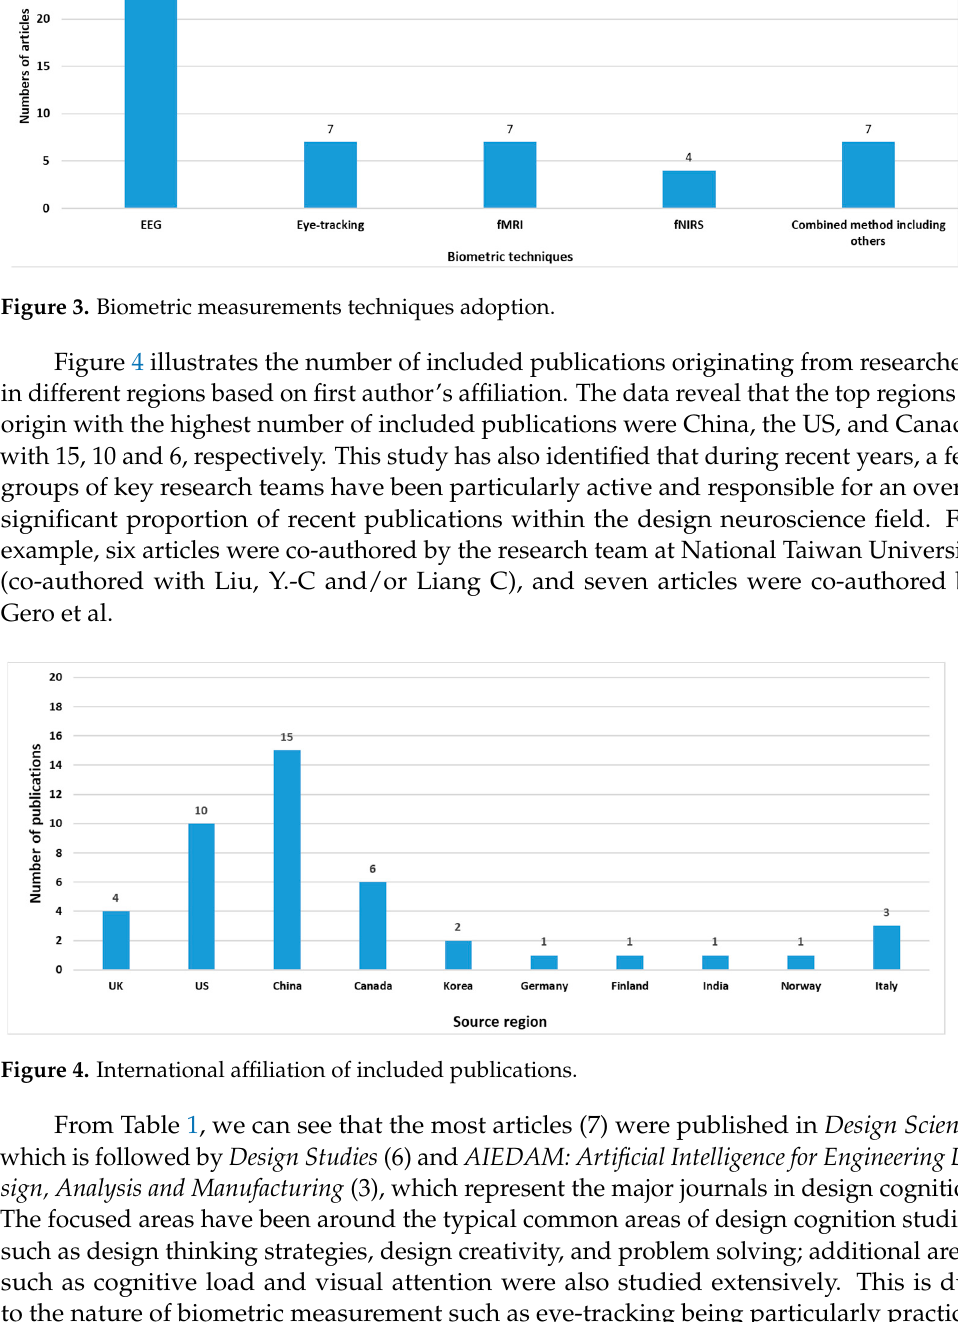
12 of 24 Figure 2. Annual publication trend of articles for biometric analysis in design cognition. 3.2. Content Analysis of Review Articles